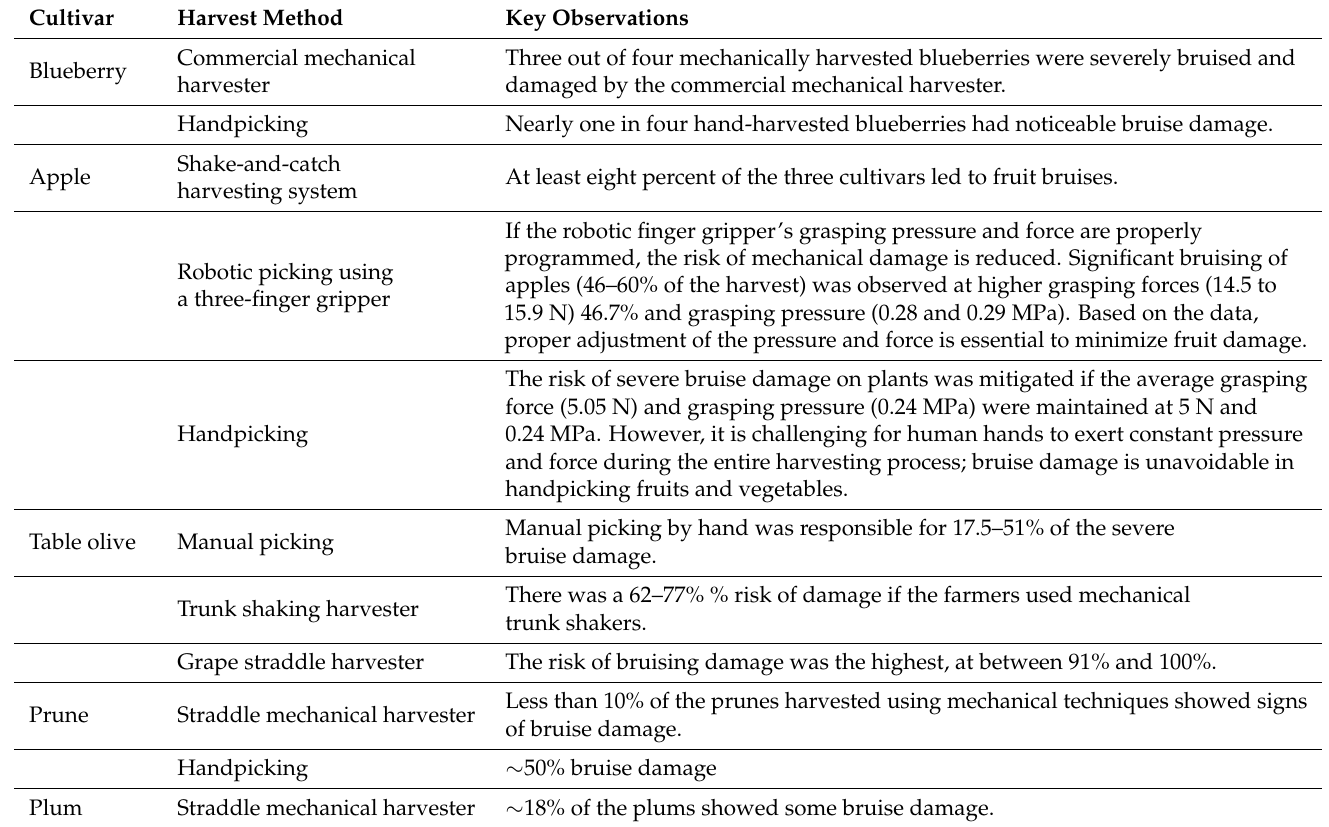
Table 2. Comparative analysis of fruit damage using mechanical harvesters, robotic grippers, and handpicking